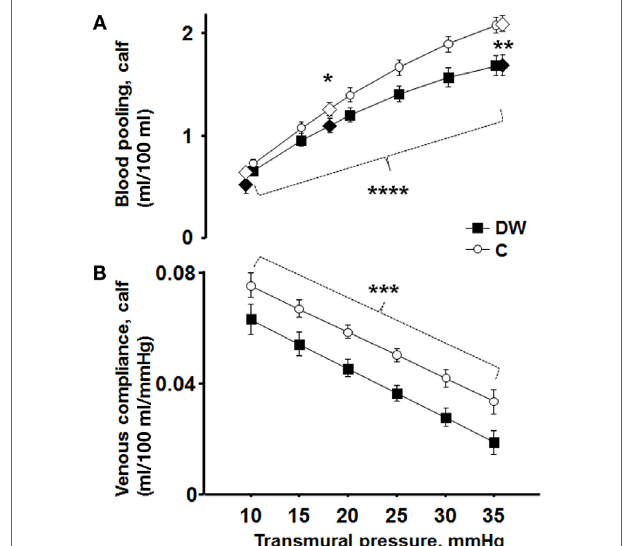
FigUre 2 | (a) Blood pooling at LBNP of 11, 22, and 44 mmHg (equivalent to transmural pressure of 9, 18, and 36 mmHg) in DW (black diamonds) and C (white diamonds). The from the quadratic regression equation calculated volume is depicted in two black lines marked every 5 mmHg (DW black boxes; C white circles). Blood pooling (ml/100 ml) was reduced in DW during LBNP of 22 mmHg ( P < 0.05) and LBNP of 44 mmHg ( P = 0.003). The shape of the line was more horizontal in DW with increased transmural pressure, i.e., blood pooling increased less with enhanced transmural pressure in DW ( P < 0.0001). (B) Corresponding calf venous compliance in DW (black boxes) and C (white circles). Venous compliance (ml/100 ml/ mmHg) was reduced in DW, both overall ( P = 0.0007) as well as during calculated venous compliance (e.g., compliance at LBNP 22 mmHg, P = 0.002).